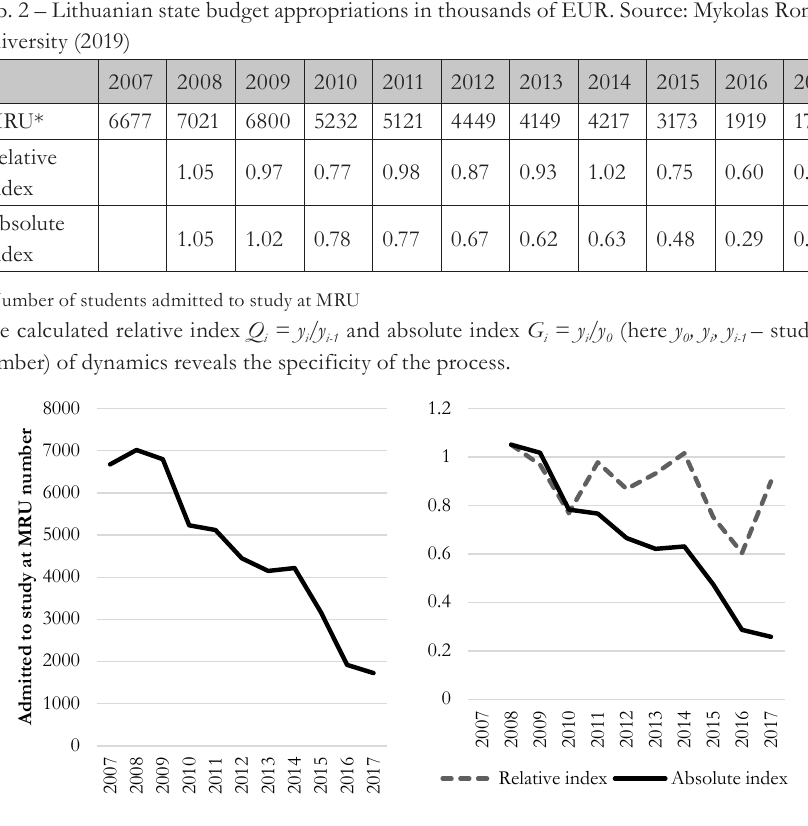
Fig. 7 – Dynamics of the number of students admitted to study at MRU. Source: Mykolas Romeris University